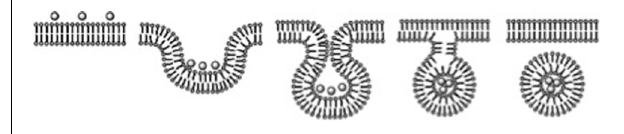
FIGURE 1 | The structure of endomorphin-1 and -2. FIGURE 2 | Endocytosis of glucopeptides (Polt,